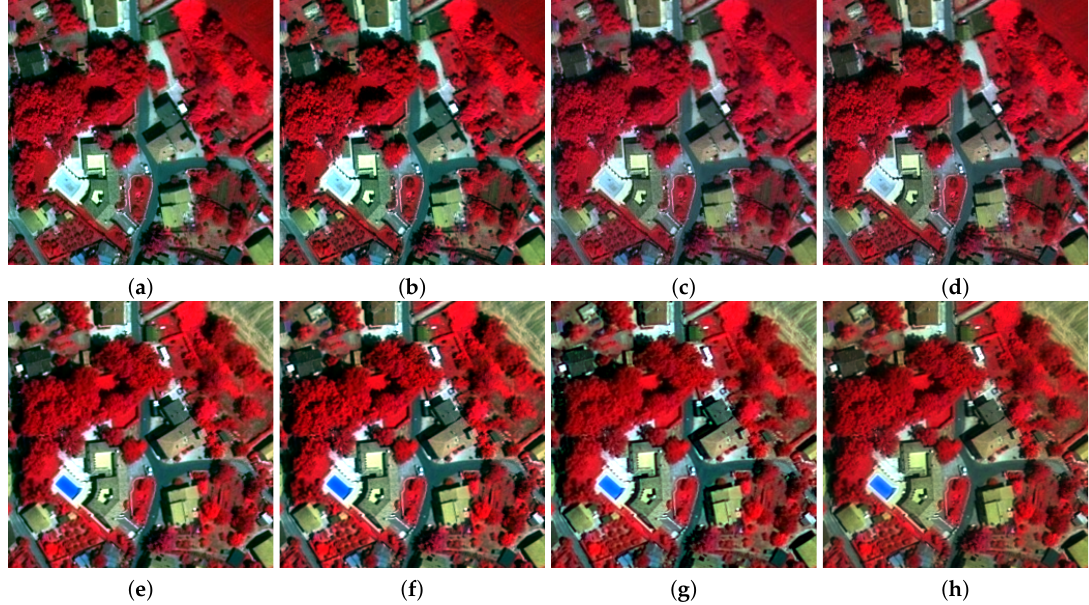
Figure 5. False color compositions (4-3-2 as R-G-B) of 256 × 256 fragments of the GeoEye-1 pansharpened images acquired ( a – d ) on 27 May 2010 and ( e – h ) on 13 July 2010. ( a , e ) CSw/oPRC; ( b , f ) CSw/PRC; ( c , g ) MRAw/oPRC; ( d , h )